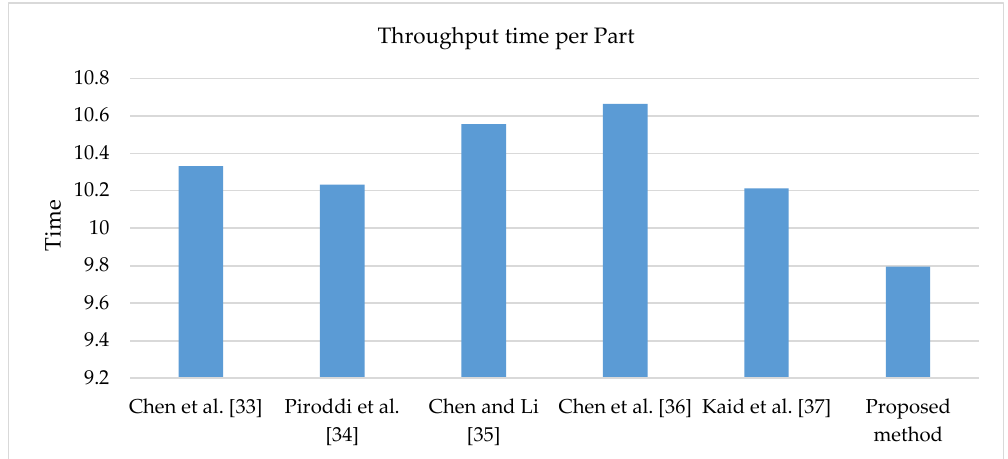
Figure 12. Comparison of the throughput time per part for the Petri net model in Figure